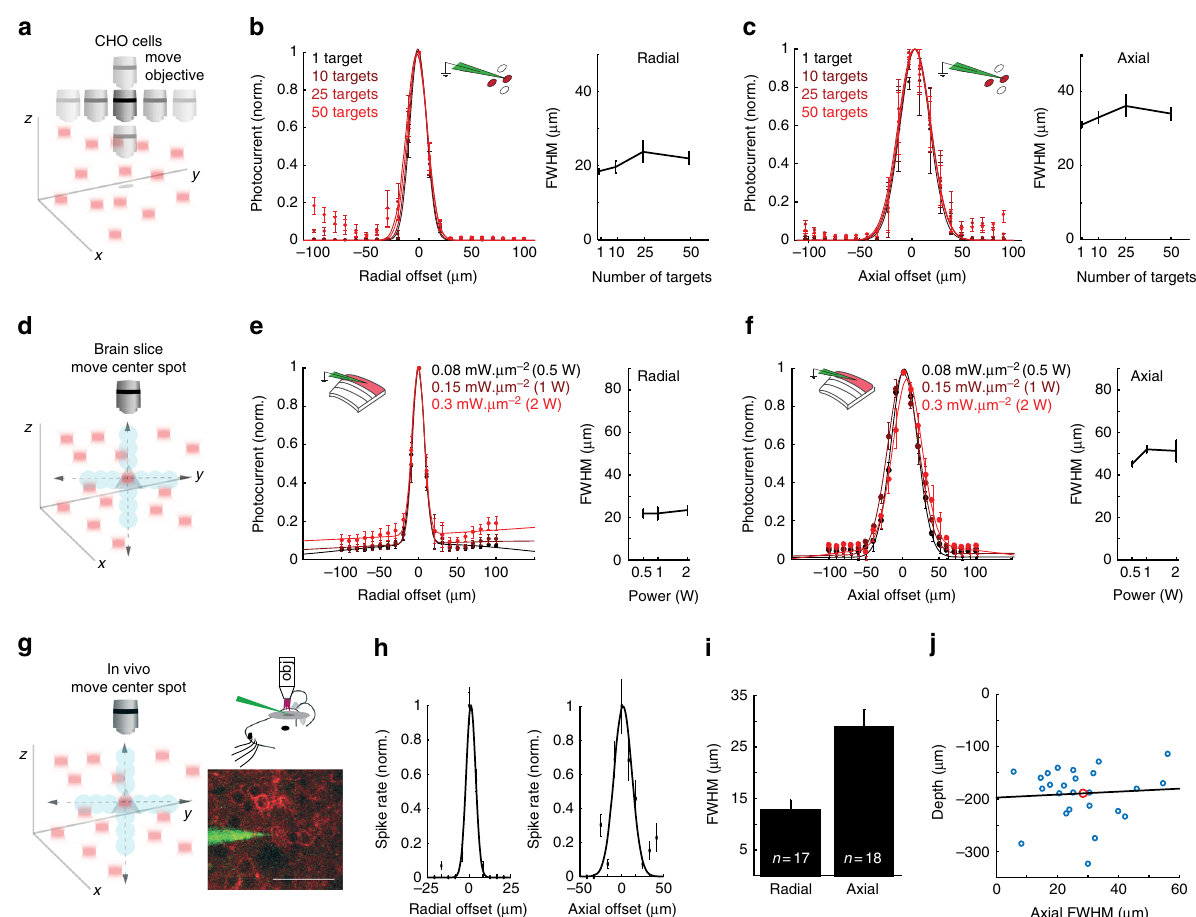
Fig. 9 Spatially precise volumetric optogenetics with 3D-SHOT. a Schematic demonstrating 3D-SHOT stimulation of a CHO cell with a single spot in a hologram targeting multiple spots in the volume. The objective was moved to measure the physiological point spread function via voltage clamp recordings. b Normalized photocurrent and quanti fi cation of FWHM as a function of radial displacement for holograms targeting 1 – 50 spots (data represent mean ± s.e.m. of n = 3 cells, p = 0.39, Kruskal − Wallis test with multiple comparison correction). c As in b but axially ( n = 3 cells, p = 0.64). d Schematic showing whole cell recordings in brain slices while stimulating multiple targets. To measure spatial resolution of 3D-SHOT, a series of new holograms was computed that displaced only the center target while holding all other spots stationary. e Photocurrent measurements from brain slices for radial digital offset of a center spot at several stimulation powers (colors, 0.5 – 2 W), quanti fi cation of FWHM as a function of stimulation power through the objective (data are mean ± s.e.m. of n = 5 neurons, p = 0.69, Kruskal − Wallis test with multiple comparison). f As in e but axially ( p = 0.11). g As in d , but for in vivo loose patch recordings; example image of a 2P guided patch of a L2/3 pyramidal neuron expressing ST-ChrimsonR-mRuby2 (scale bar = 50 µ m). h Radial and axial physiological point spread functions showing resolution of 3D-SHOT while targeting an ensemble of 21 neurons while only the center spot was moved (data represent mean and s.e.m. from an example neuron). i Bar graph showing mean ± s.e.m. of the radial and axial PPSFs from targeted in vivo patch while stimulating 21 cells ( n = 17 radial and n = 18 axial). j Scatter plot showing axial FWHM vs. the depth below the cortical surface of individual neurons (axial PPSF is from experiments with 1 or 21 holograms, n = 24). Red dot indicates the mean values, and the black line is the line of best fi t — within this range, cortical depth can explain none of the variance in axial FWHM ( R 2 = −